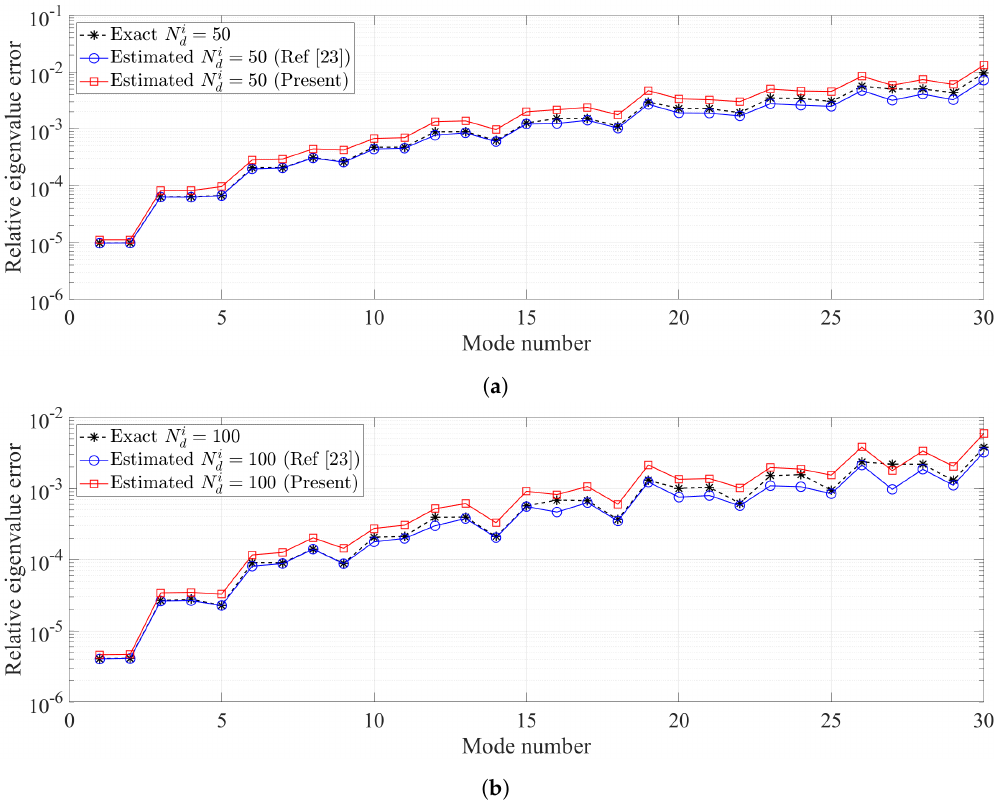
Figure 3. Comparison of the error estimator from the previous work [23] and the new error estimator derived in Equation (43). The new error estimator gives the upper bound results for the different number of dominant modes N i